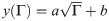
Refined data analysis for local marriages in Germany.Panel a: log-log scale plot of LMαi,y versus Γαi,y, where different regions are denoted in different colours and symbols, as explained in the legend. These data are properly binned (green squares) and best-fitted (solid line) by y(Γ)=aΓ+b, in agreement with the theoretical result (2). The best-fit coefficients are a = 1.87 and b = 8.62 ⋅ 10−5. Notice that the parameter b accounts for the standard deviation associated to binned data. In general, the various regions seem to be homogeneously scattered around the best-fit curve. In the insets we show, as examples, the data pertaining to two selected regions, namely Bayern (upper inset) and Sachsen (lower inset). Notice that for both the insets the best-fit previously obtained for the whole data set (solid line) still provides a very good fit. Panel b: For each region we calculate ρ
α, as defined in the text and deepened in the Theoretical Protocol Section. The horizontal line is drawn as a reference for the unitary value. Notice that for most regions the deviation with respect the unitary value is within the error bar. The largest deviation from the unitary value is for two city-states, namely Hamburg and Berlin. Given that all the regions (a few cases apart) are compatible with the overall best fit no further analysis on territorial homogeneity is performed. The colormap presented in panel c highlights the deviation of ρ
α with respect to the unitary value.